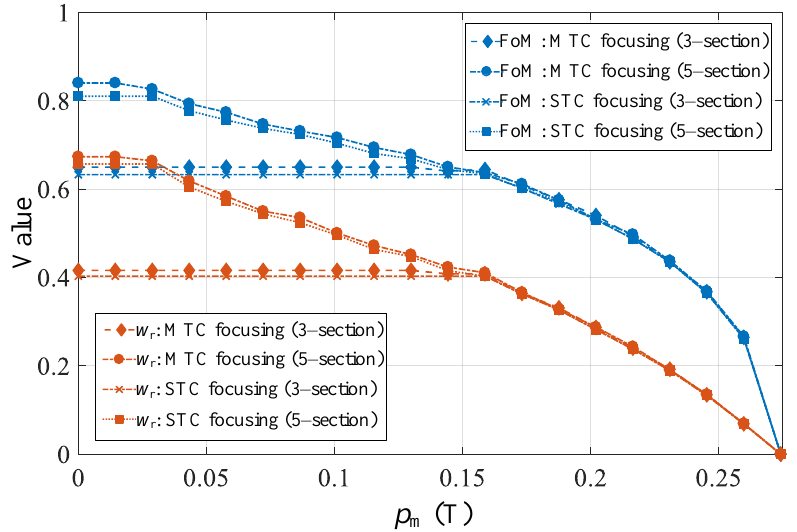
Figure 9. FoMs of the MTC and STC at different p m values.